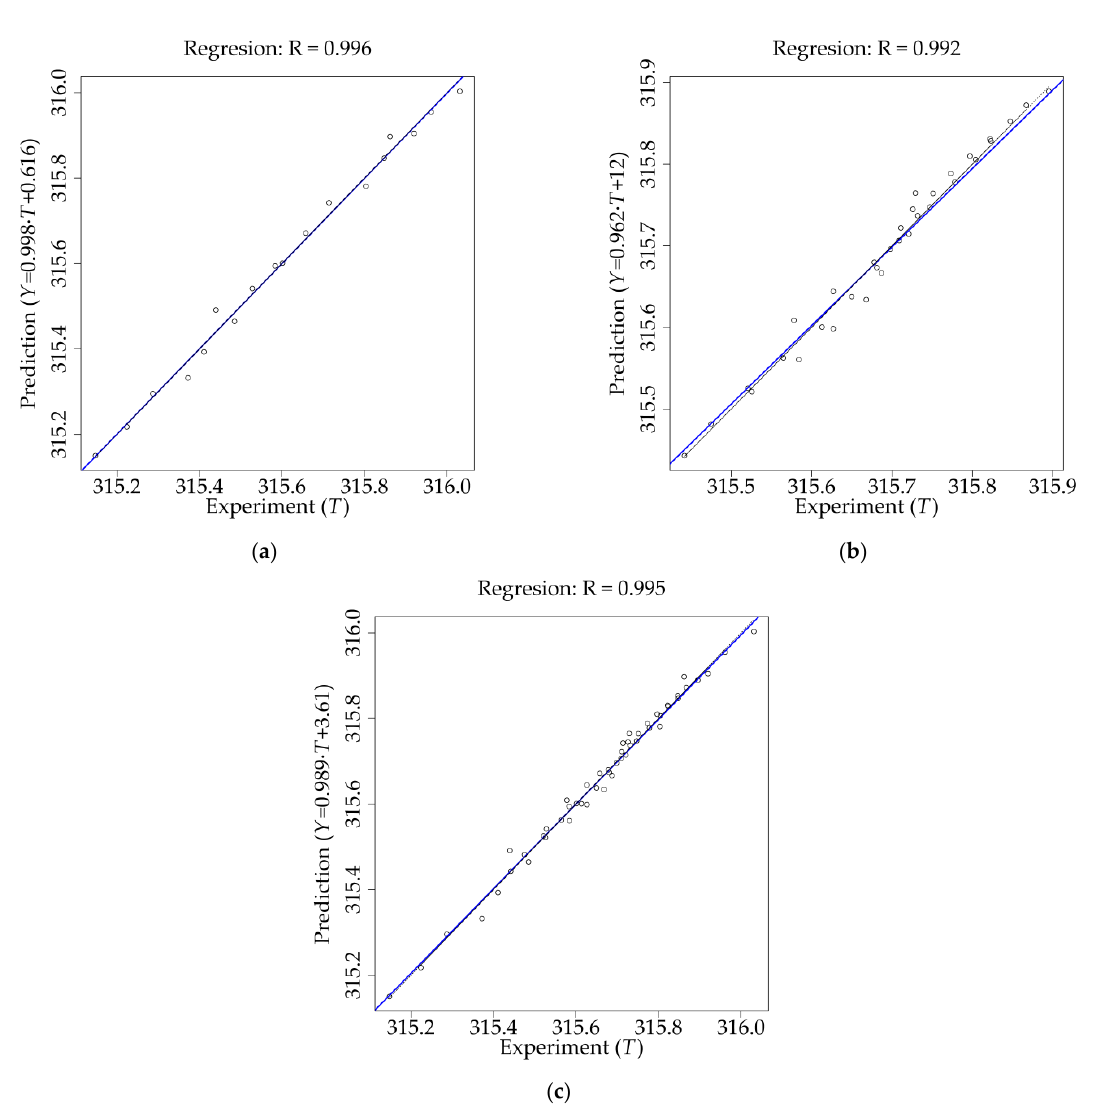
Figure 10. Regression plots for an artificial neural network with Levenberg – Marquardt back-prop-